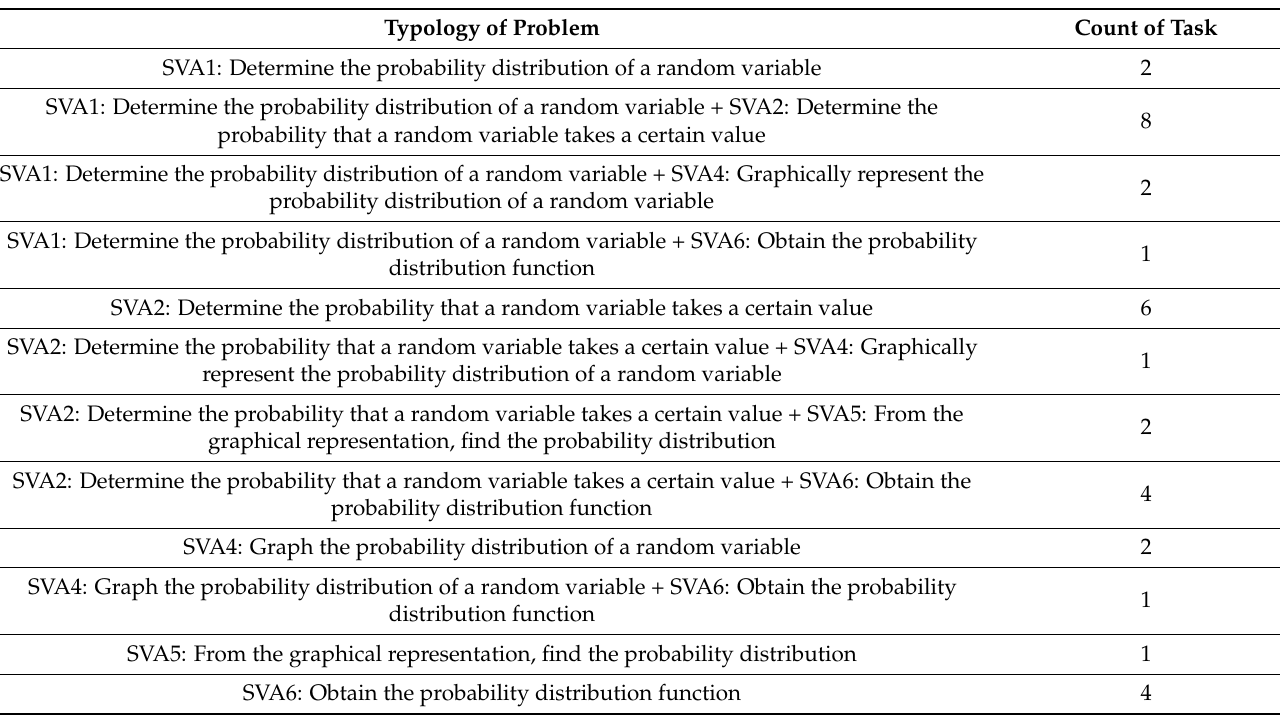
Table 1. Classification by type of problem (Source: Prepared by the authors). Typology of Problem Count of